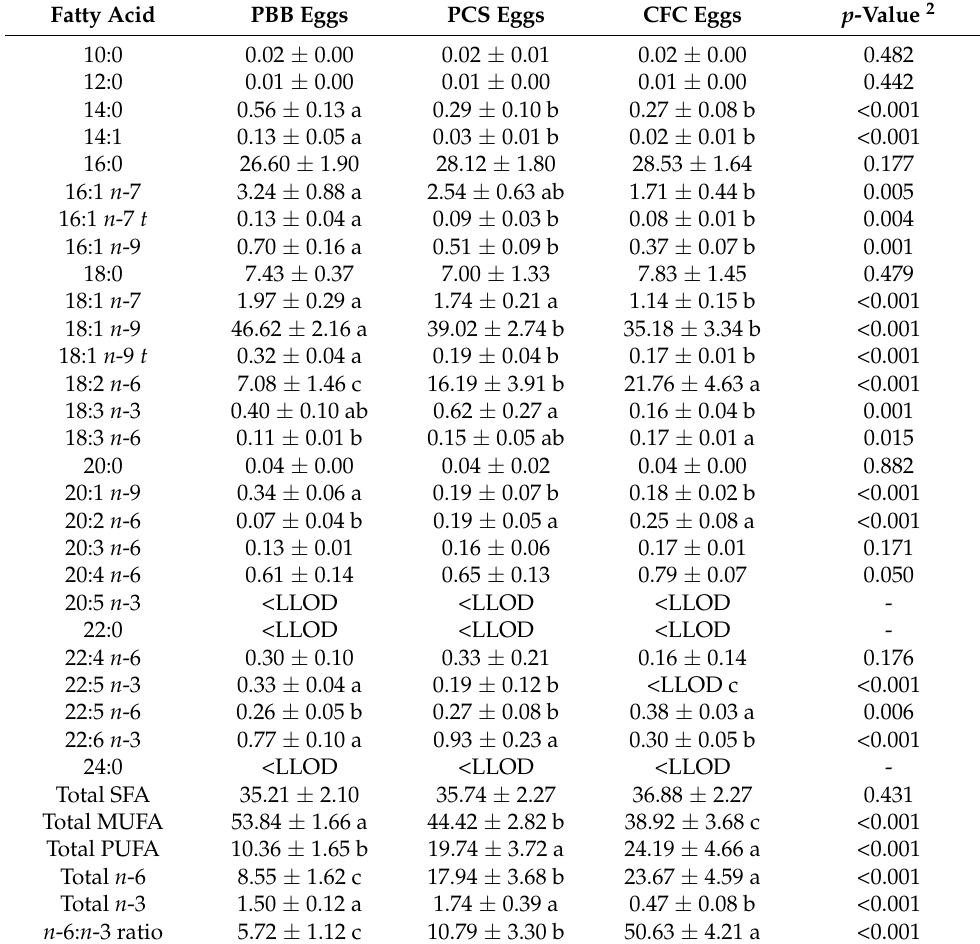
Table 5. Fatty acid profile of the egg yolks (% of total fatty acids) 1